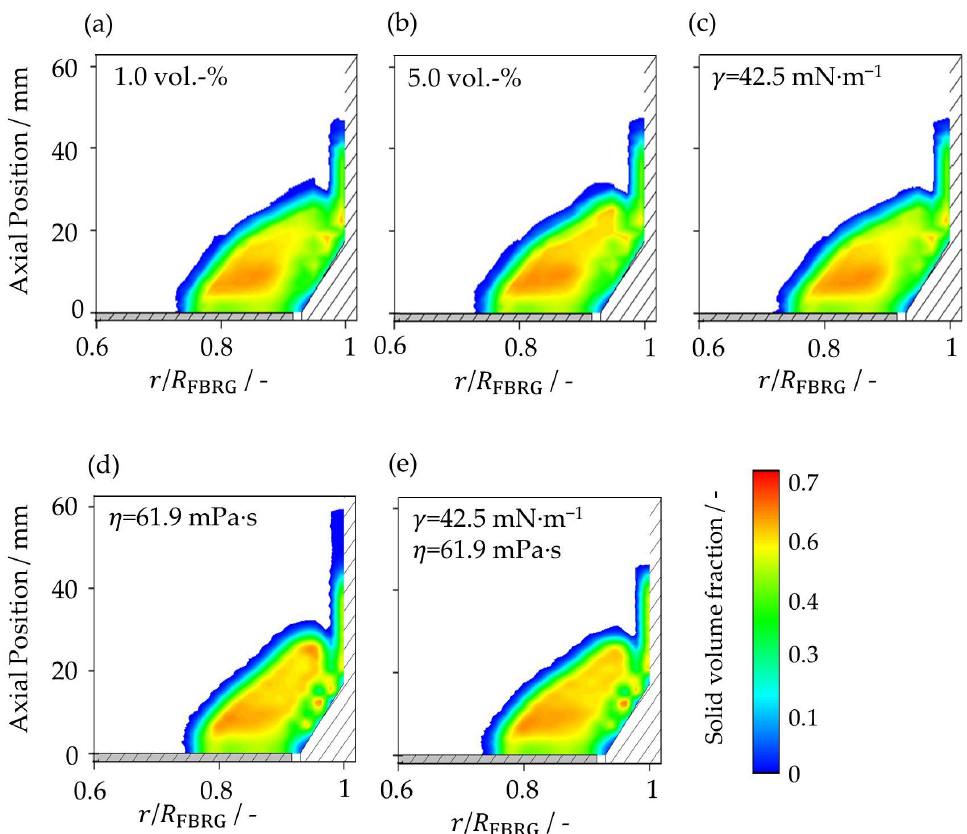
Figure 3. Poloidal distribution of solid volume fraction for studied cases (Table 3): ( a ) liquid loading of 1 vol.-%, ( b ) liquid loading of 5 vol.-%, ( c ) surface tension of 42.5 mN∙m −1 , ( d ) viscosity of 61.9 mPa∙s, and ( e ) surface tension of 42.5 mN∙m −1 and viscosity of 61.9 mPa∙s.